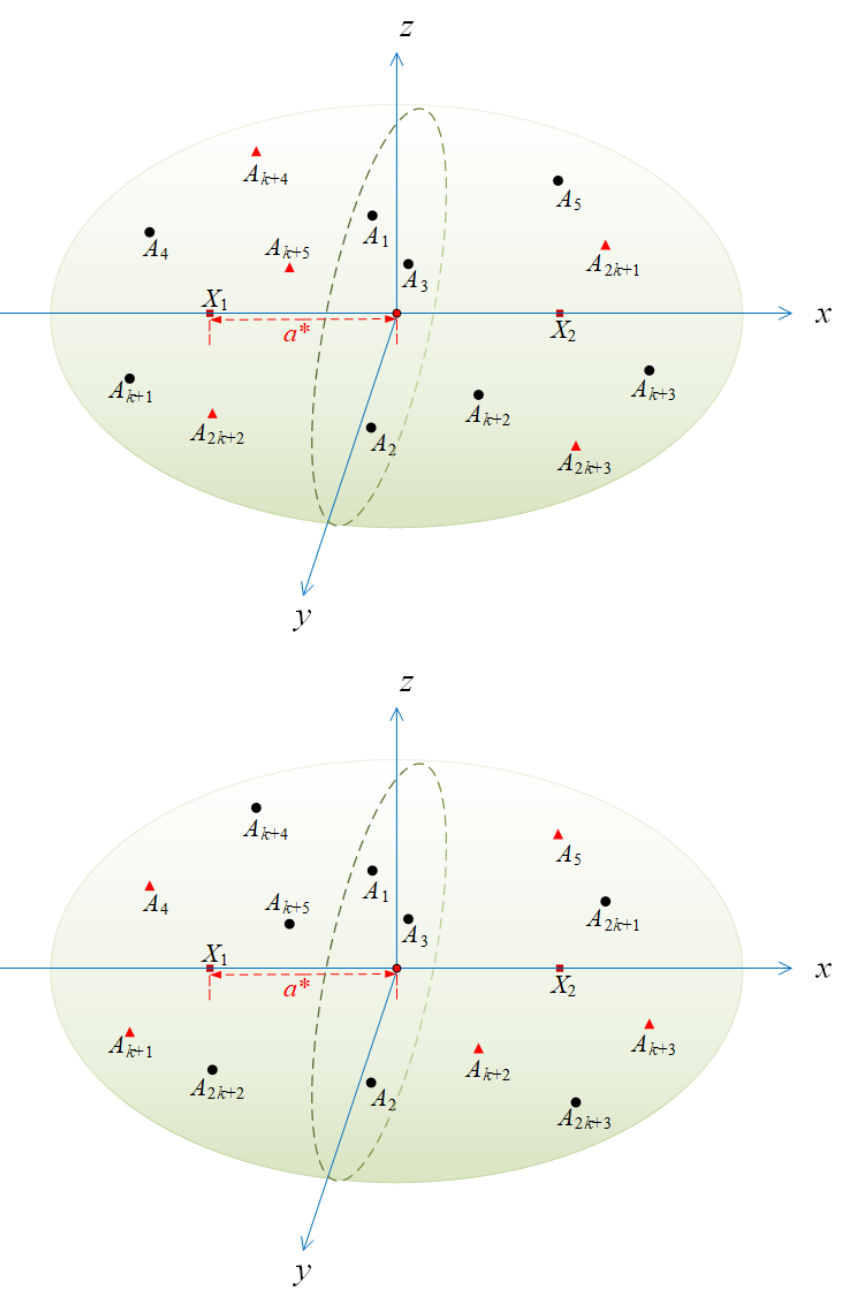
Figure 6. Two scenarios to prove localization bound theorem (Case-1 in upper, and Case-2 in